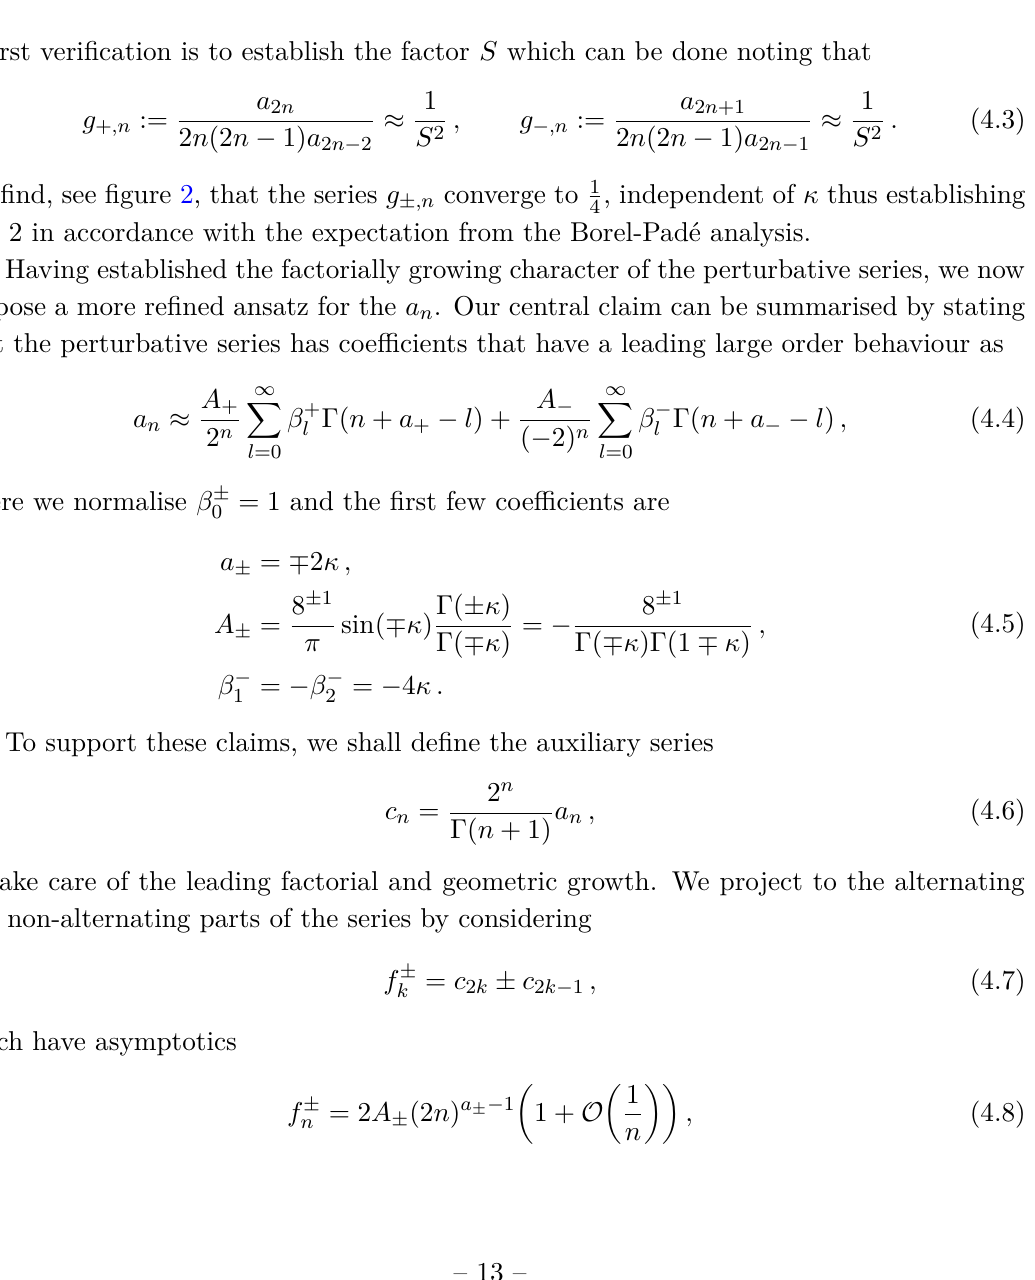
Figure 2. The series g + ,n (left) and g − ,n (right) given by eq. (4.3) displayed for κ = 0 . 6 . Circle markers indicate the raw data, square markers the second Richardson transformation with acceler- ated convergence. The final values of the second Richardson transform differ by 0 . 11% and 0 . 05% respectively from the expected value 1 4